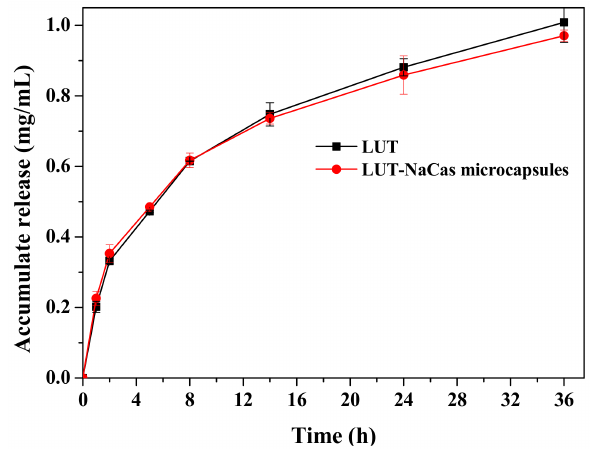
Figure 5. The in vitro release of lutein (black) and lutein-loaded NaCas microcapsules (red) from dialysis bag (MW: 8000–14,000 kDa) at 37 ◦ C during a 36 h